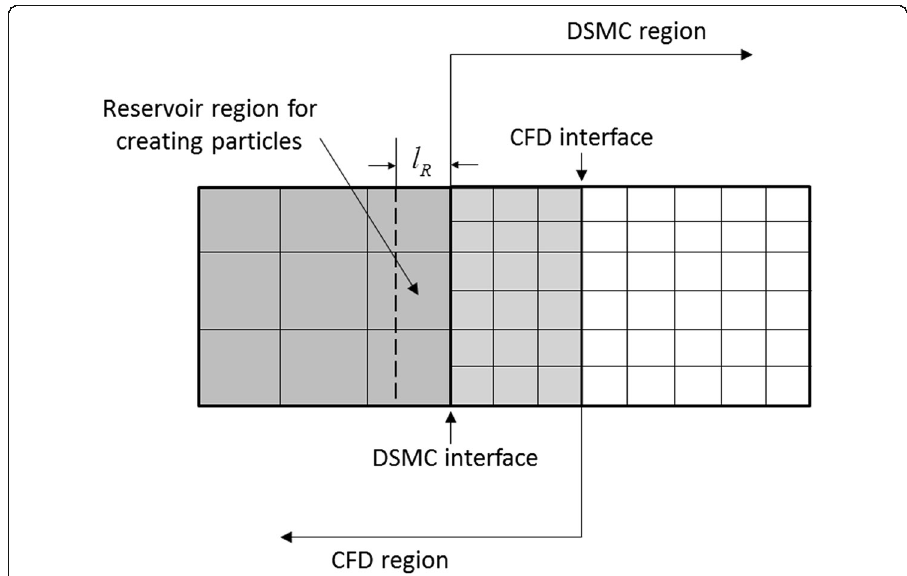
Fig. 1 Schematic of a typical domain decomposition hybrid CFD-DSMC